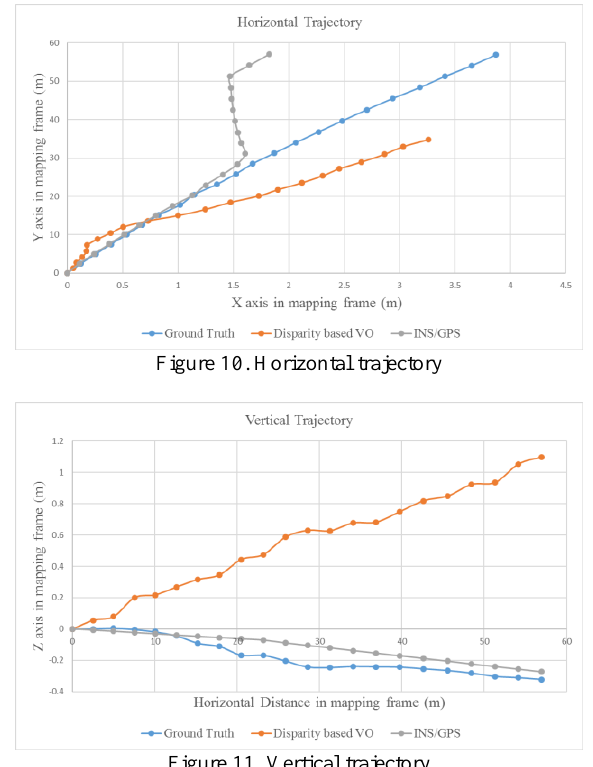
Figure 11. Vertical